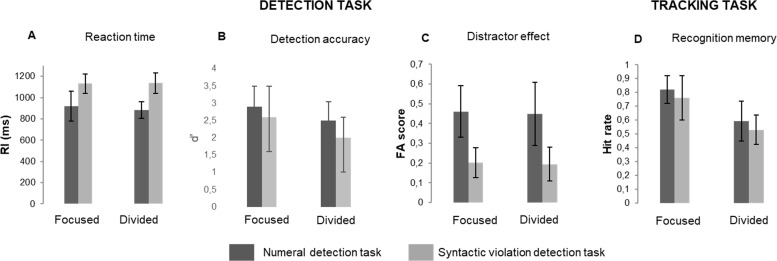
Group average (N = 25) performance in the detection (indexed by RT and d’; panels A and B, respectively), the ratio of detection task FAs (responses elicited by distractors) to the total of the non-target responses (i.e., responses neither categorized as hits nor as false alarms; panel C), and performance in the tracking task (recognition memory performance; panel D), separately for the numeral (dark grey bars) and the syntactic violation task (light grey bars) and for the focused (left) and divided attention condition (right). Line bars represent standard errors.